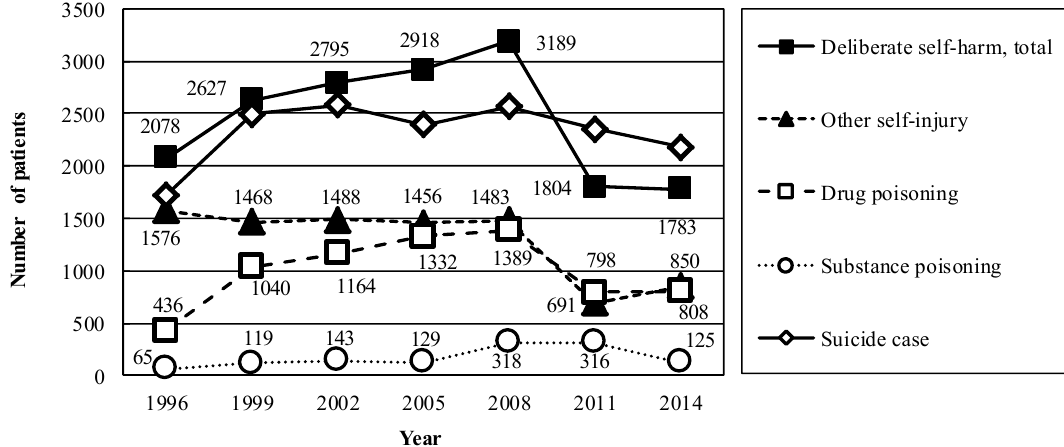
Figure 2. Estimated numbers of patients admitted to hospital because of deliberate self-harm and subsequently discharged, for every third September between 1996 and 2014.